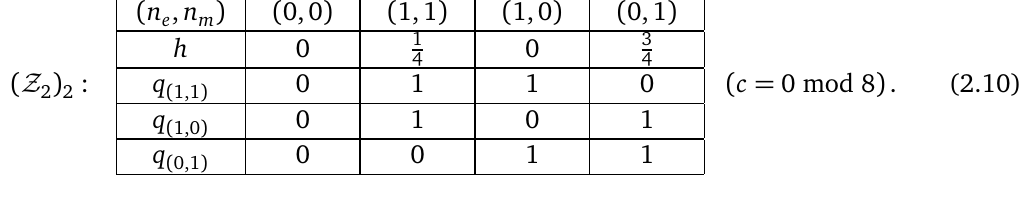
gauge theories. The number next to the 2 line used for the fractionalization map. 2